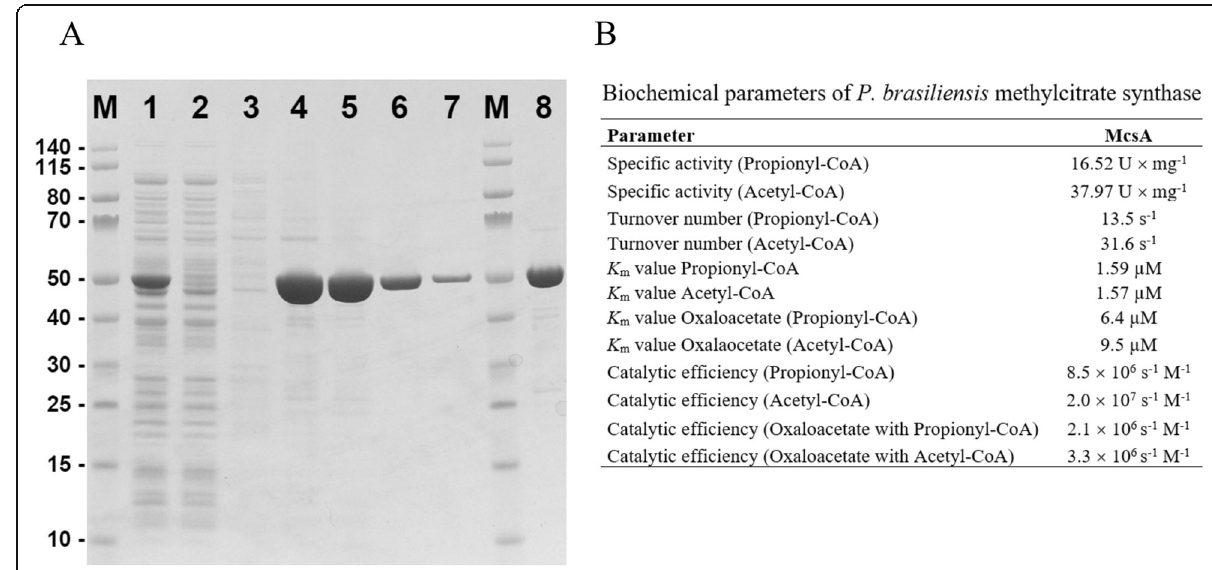
Fig. 3 Production, purification and biochemical parameters of recombinant MCS. a -SDS-PAGE of different purification stages of MCS; Lane M – molecular weight marker, lane 1 whole bacterial cell lysate, lane 2 – flow-through from the Ni-resin, lane 3 – wash fraction through the